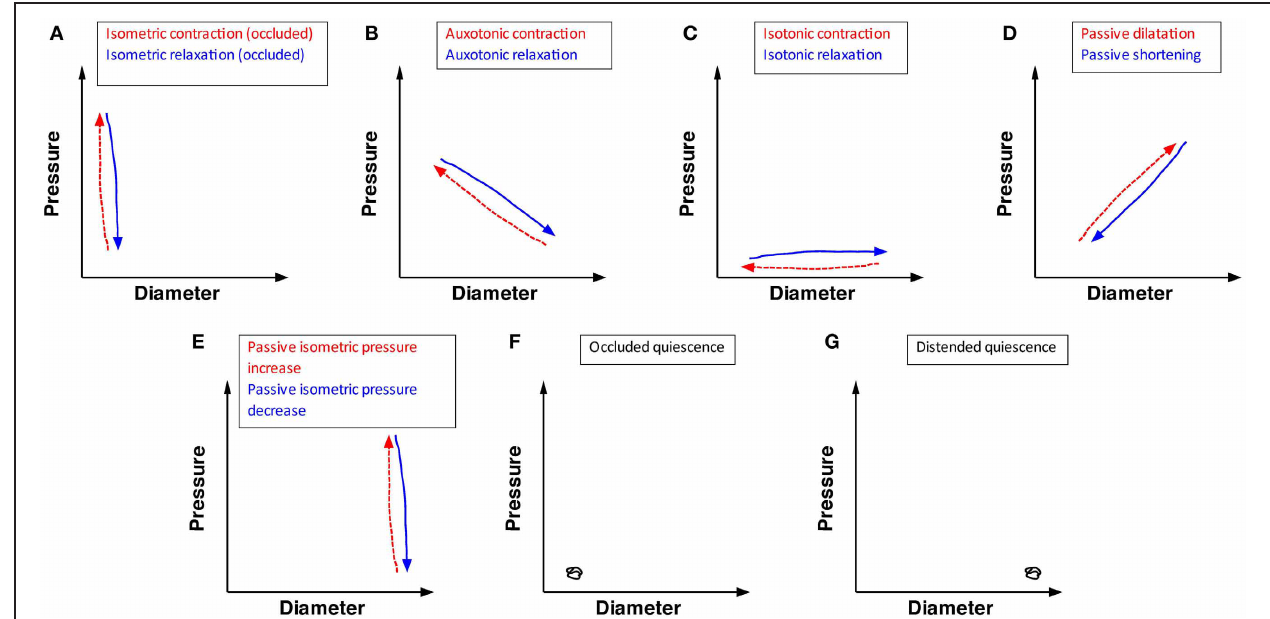
relaxation (blue arrow) indicates an increase in diameter with no change in pressure. (D) Passive dilation (red hatched arrow) indicates an increase in pressure with a corresponding increase in diameter. Passive shortening (blue arrow) indicates a decrease in diameter with a corresponding decrease in pressure. (E) Passive isometric pressure increase (red hatch arrow) indicated an increase in pressure in a distended region of gut (with no change in the gut diameter). Passive isometric pressure decrease (blue arrow) indicates a decrease in pressure in a distended region of gut (with no change in gut diameter). (F) Occluded quiescence indicates no change in pressure or diameter in an occluded region of gut. (G) Distended quiescence indicates no change in diameter and pressure in a distended region of